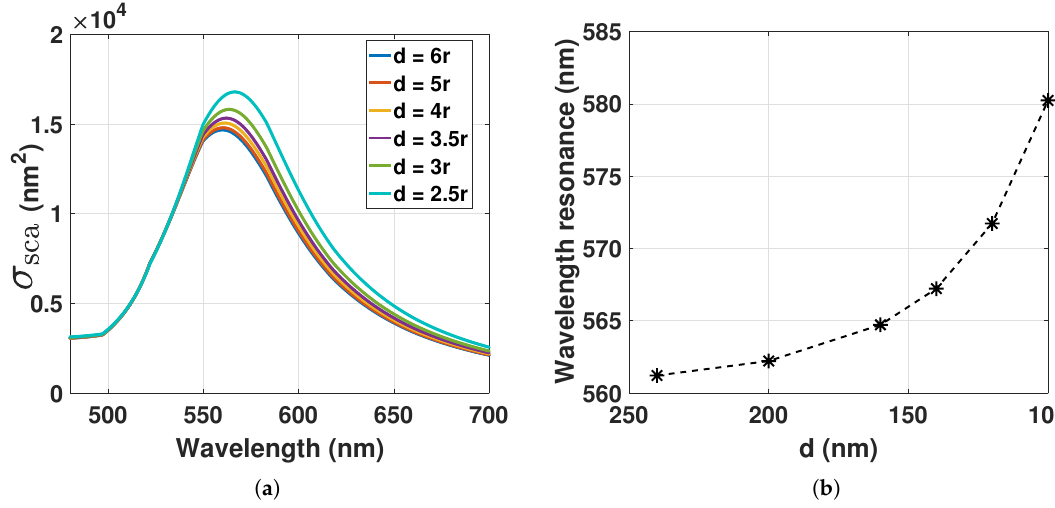
Figure 3. ( a ) Scattering cross-section computed from Equation (1) with L = 1 of GNP with 80 nm in diameter for the decrease in d ; ( b ) LSPR peak position from Figure ( a ) as a function of decreasing d . n m =